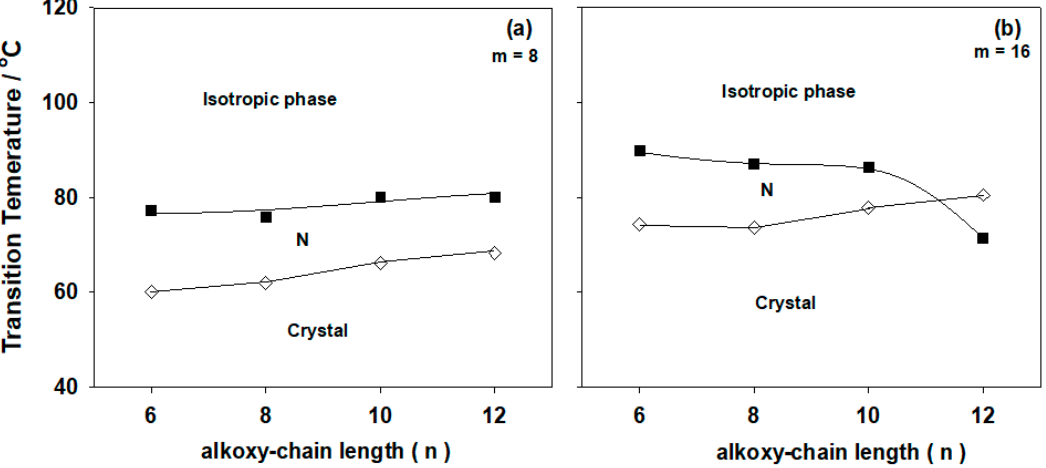
Figure 2. Dependence of the alkoxy-chain length of the acid component ( n ) of the lateral Cl azopyridines ( I m ) on the mesophase behavior of the 1:1 supramolecular hydrogen-bonded complexes ( a ) m = 8; ( b ) m = 16.